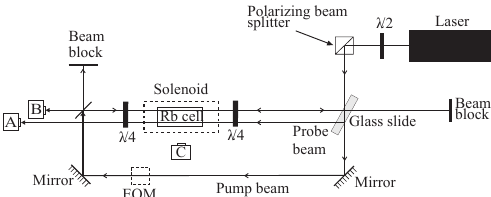
Figure 3. Saturated absorption setup used in emission and absorption spectroscopy, Zeeman shift, and laser frequency stabilization experiments. A quarter-wave plate represented by λ /4 is used to produce circularly polarized laser beams. A half-wave plate, represented by λ /2, is used to control the ratio of power reflected and transmitted by the polarizing beam splitter. “A” and “B” represent photodiodes used for recording absorption spectra. The absorption of a weak probe beam that serves as a reference is recorded by photodiode A. The absorption of a weak probe beam in the presence of a strong counter-propagating pump beam is recorded by photodiode B. Electronic subtraction of the signals from these photodiodes gives a Doppler-free spectrum shown in Figure 2c. Photodiode C is used to record right-angle fluorescence. Locations of the electro-optic phase modulator (EOM) used in the emission and absorption spectroscopy experiment and the solenoid used in the Zeeman shift experiment are shown by dashed lines. In experiments with the EOM, the two weak probe beams are blocked and only the pump beam remains